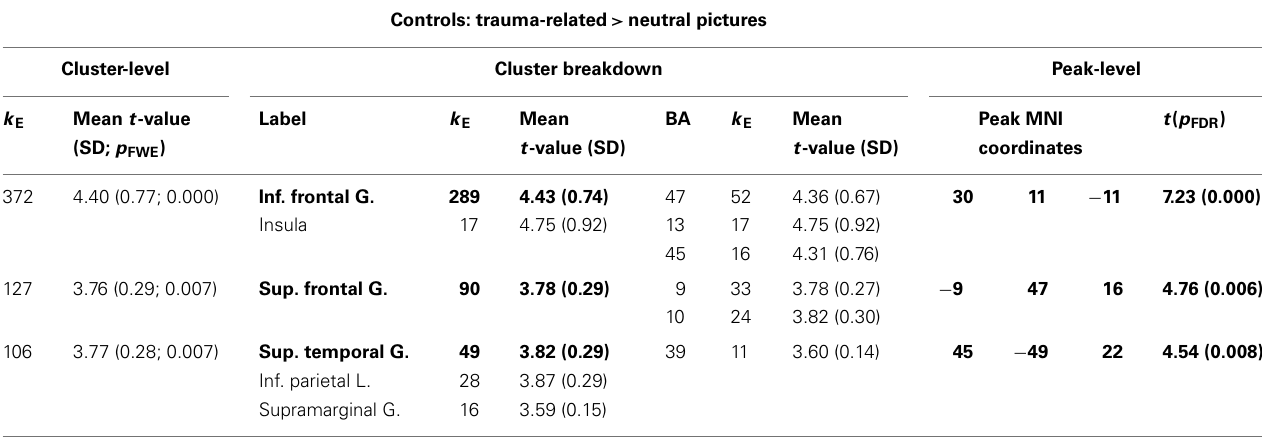
Table 4 | Control participants: comparison of response to trauma-related compared to neutral pictures .